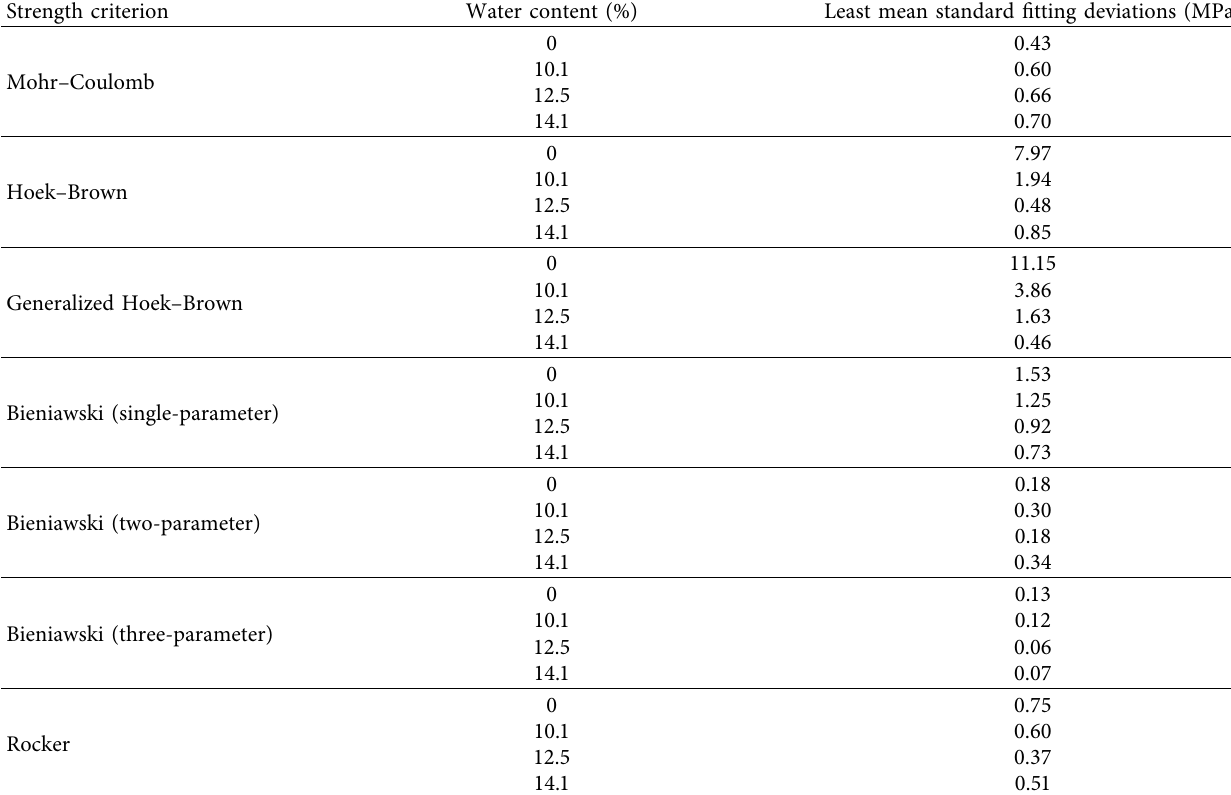
Table 3: Least mean standard fitting deviations of each strength criterion.